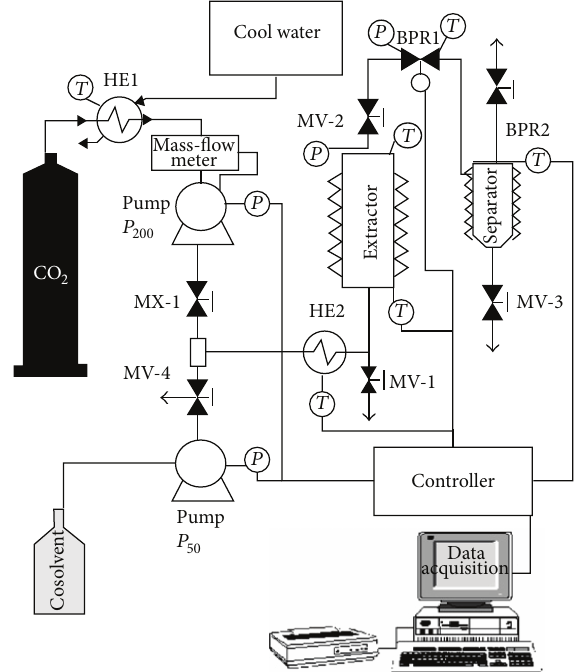
Figure 2: Schematic diagram of the equipment used for the